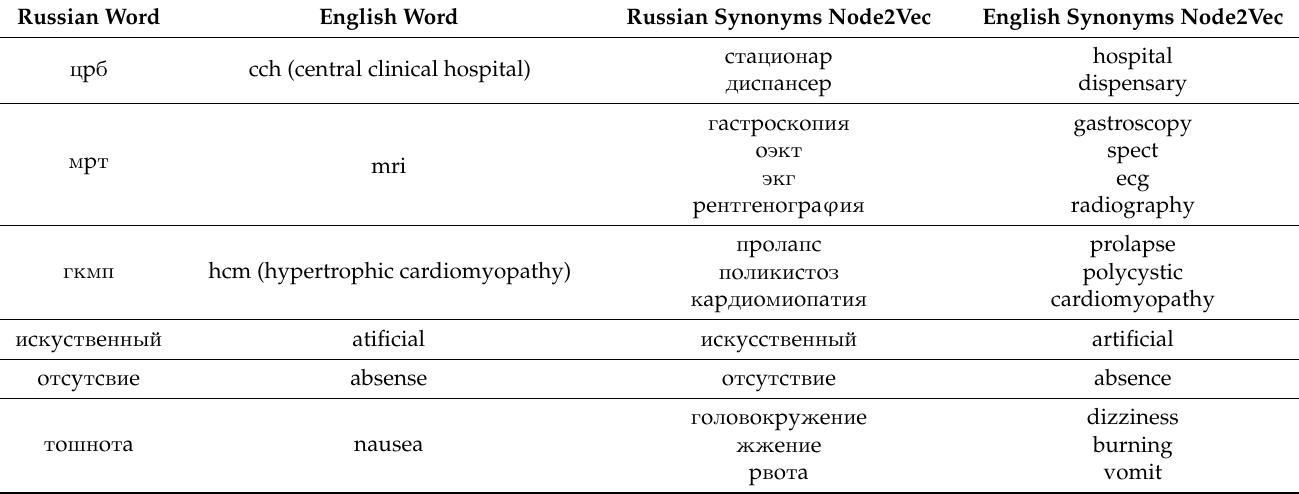
Table 2. Examples of words similar by cosine distance defined by Node2Vec.